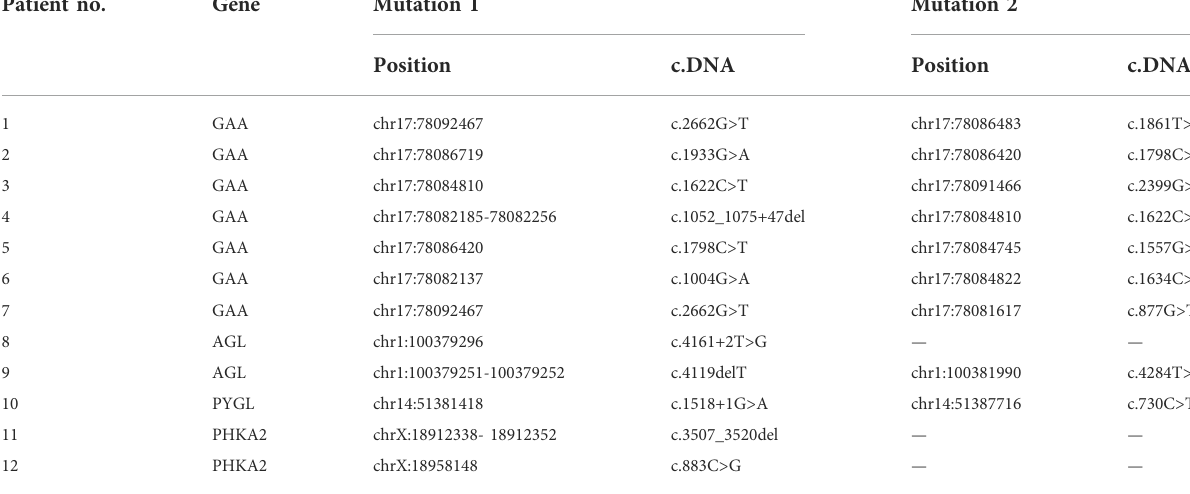
TABLE 3 | Chr positions of the variants in GAA, AGL, PHKA2 and PYGL gene. Patient no.